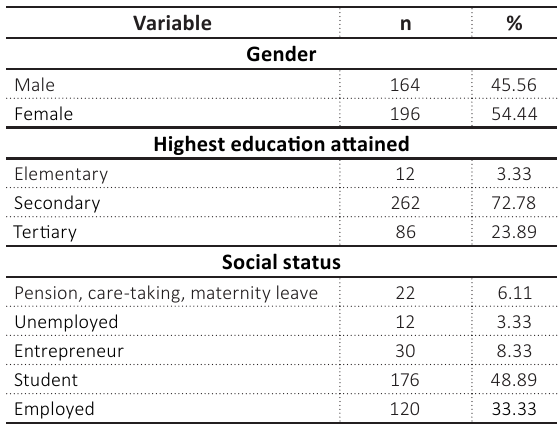
Table 2. Identification characteristics of